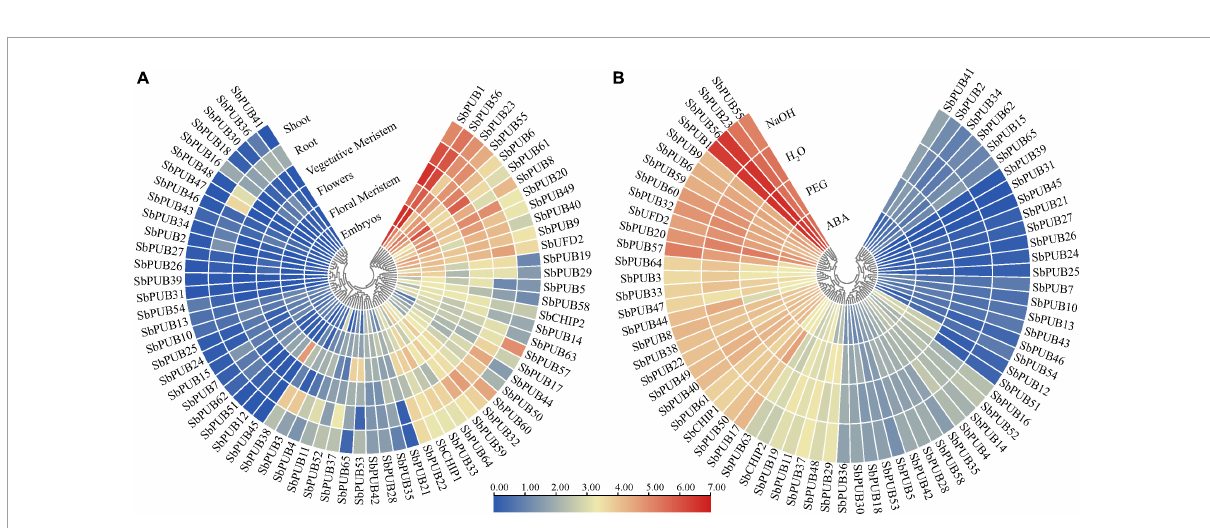
FIGURE7 Heatmap of tissue-specific expression and abiotic stress expression of sorghum U-box genes. (A) Expression of U-box genes in different tissues. (B) Expression of U-box genes under the influence of NaOH, ABA, and PEG. The color bar represents the log2 expression level of each gene (FPKM, fragments per kilobase of exon per million fragments mapped). Color bar annotation is included at the top of the image. The heatmap is colored according to expression values, with blue, yellow, and red representing at low, medium, and high transcription abundance,